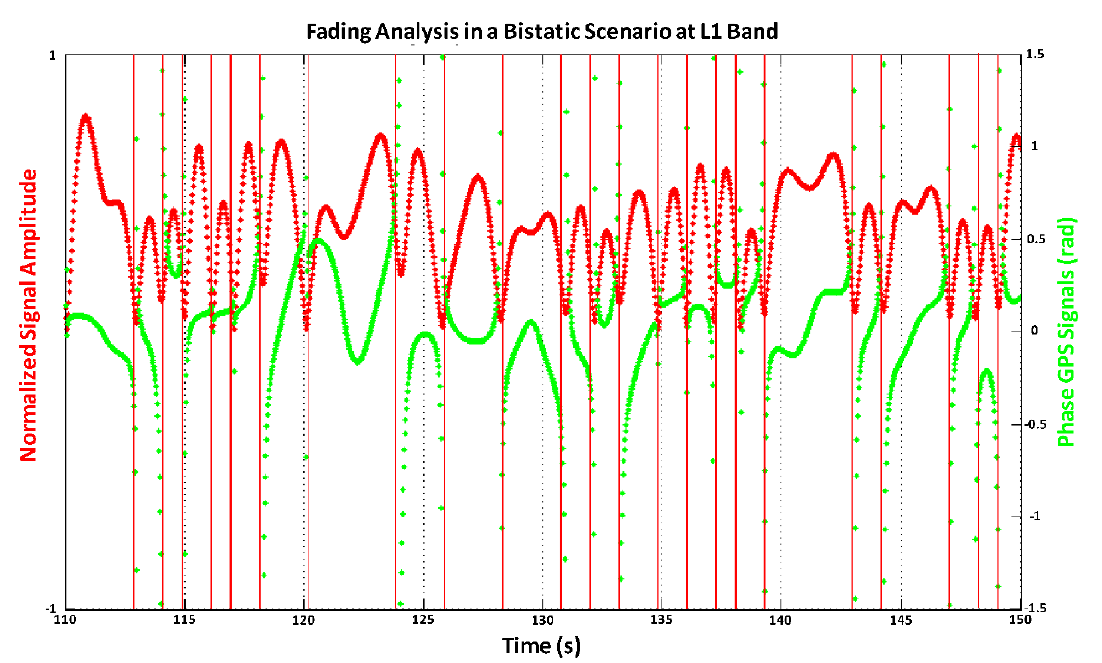
Figure 8. Normalized reflected signal power amplitude fluctuations due to the phase (after retracking) changes induced by the scattering surface. This analysis has been performed with a SWH = 36 cm and an elevation angle of θ = e